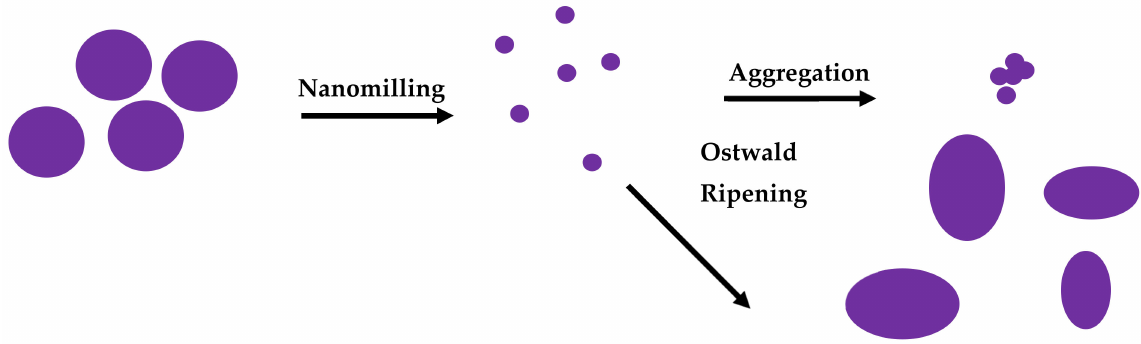
Figure 3. Schematic representation of possible mechanisms of particle interaction that may occur during wet media milling (Adapted from